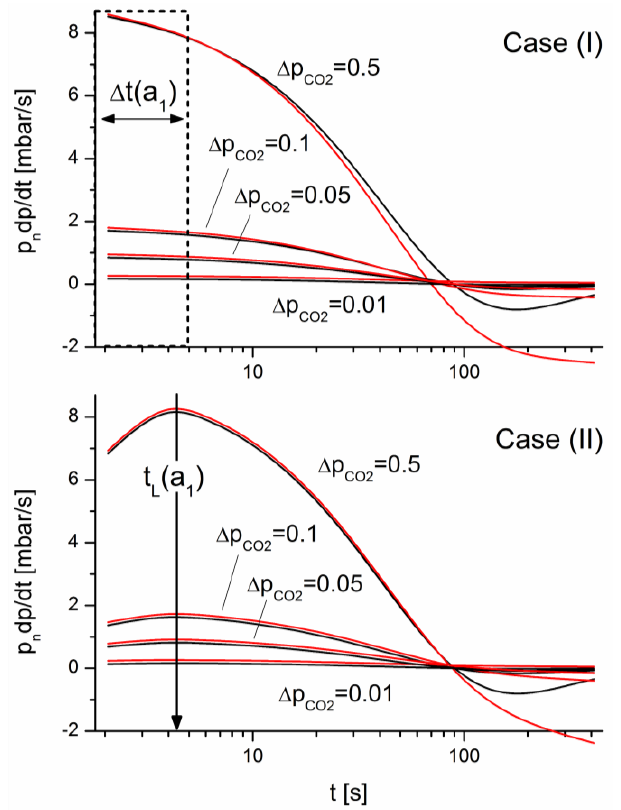
Figure 8. Comparison of derivations dtdp / (black) for the pressure for cell I and dtpd /)(  (red) for the differential pressure for paired cells I and II for differing amounts p  added to air. The calculations consider 100  n terms. To improve the visualization, 2 CO a vertical offset of 0.1 mbar/s was added to the red lines. The deviations behaved nearly identically within the displayed region )( quantification of a gas